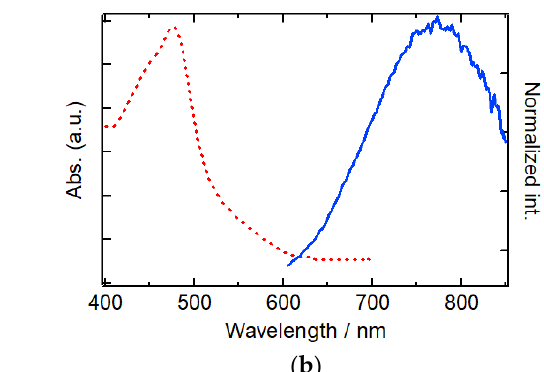
( b ) Figure 5. ( a ) Absorption and emission spectra and ( b ) cyclic voltammograms of complex 1 in acetonitrile before and after the addition of 1.6 eq. of TfOH. 3. Materials and Methods 3.1. Materials All solvents and chemicals were reagent grade, purchased commercially, and used without further purification unless otherwise noted. The naphthoquinone-annelated lig-